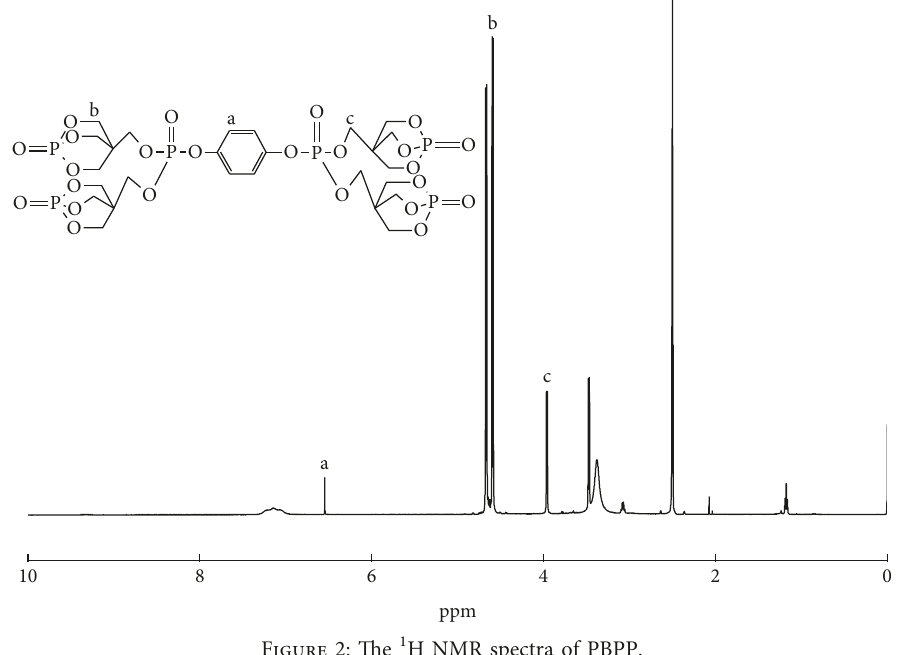
Figure 2: The 1 H NMR spectra of PBPP.